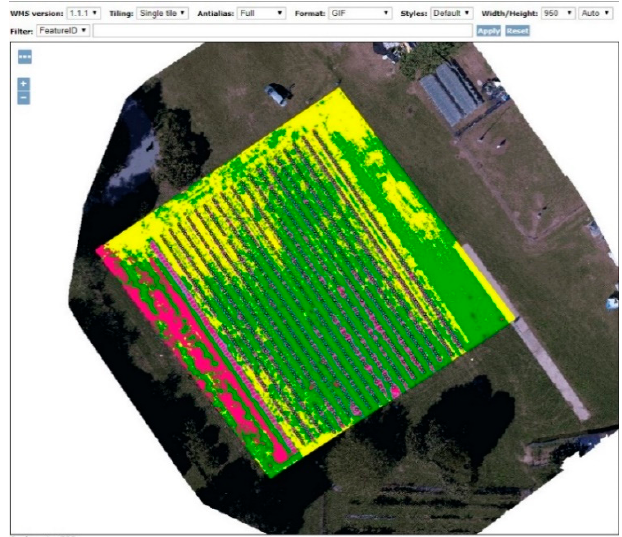
Figure 13. Workspace creation for the Grugliasco vineyard WebGIS.